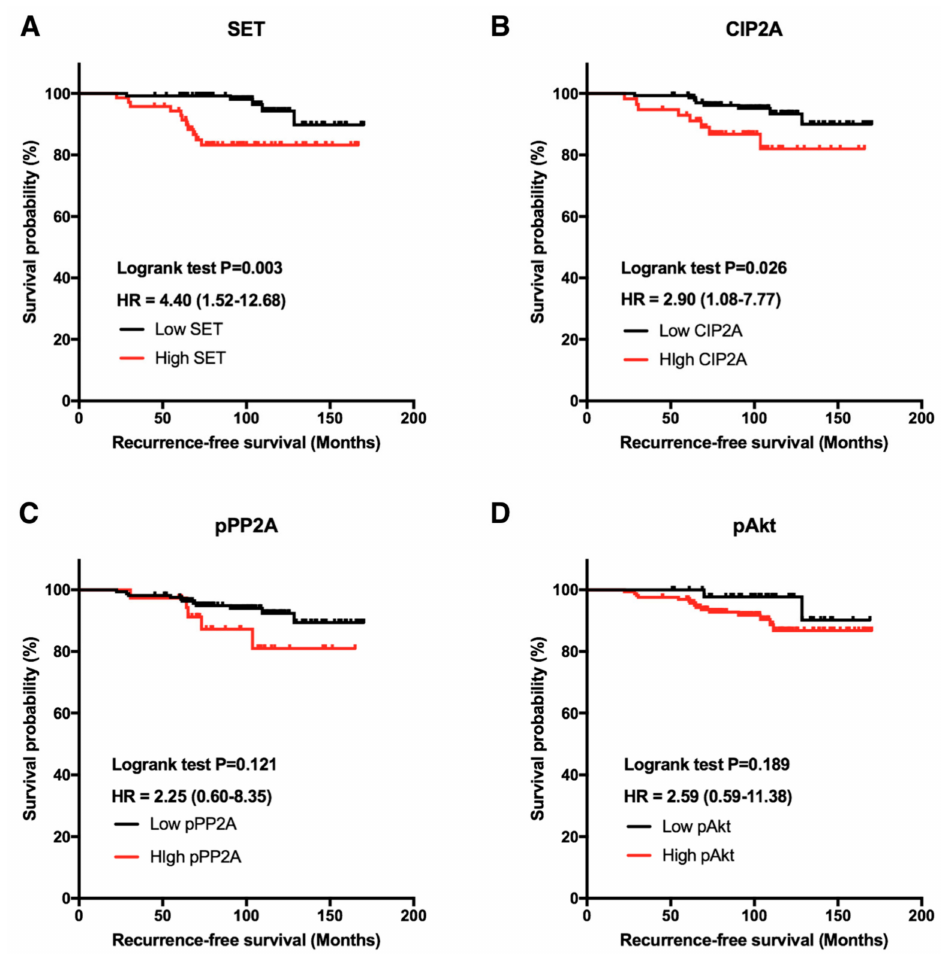
Figure 1. Clinical significance of protein biomarkers in human breast cancer patients. Kaplan–Meier analysis of the influence of SET ( A ), CIP2A ( B ), pPP2A ( C ), and pAkt ( D ) expression on recurrence-free survival (RFS) in patients with estrogen receptor (ER)-positive breast cancer receiving adjuvant